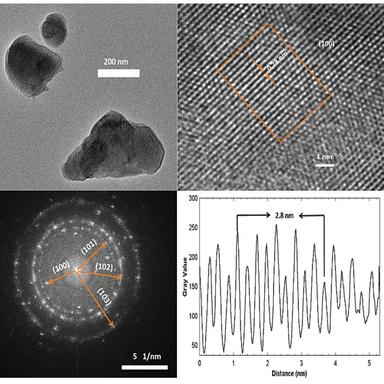
Detailed TEM characterization of annealed sample.